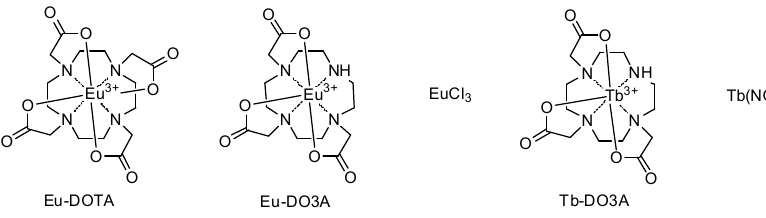
Figure 1. Structures of Eu 3+ and Tb 3+ complexes evaluated for the detection of ciprofloxacin (Cipro).